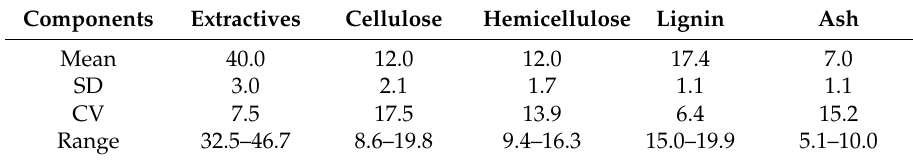
Table 1. Summary of chemical composition of calibration set. All data (% w / w) are on a moisture-free basis.